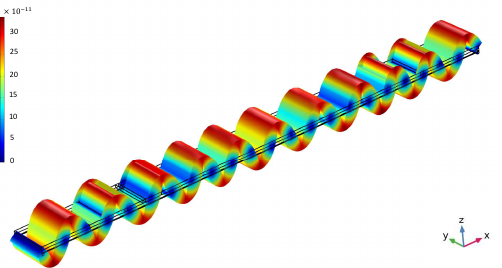
Figure 4. Time-domain simulation of the lamb wave illustrating the wave propagation and the total displacement of each part of the device at 216 ns with an input signal frequency of 86 MHz and metalization ratio of 85%.